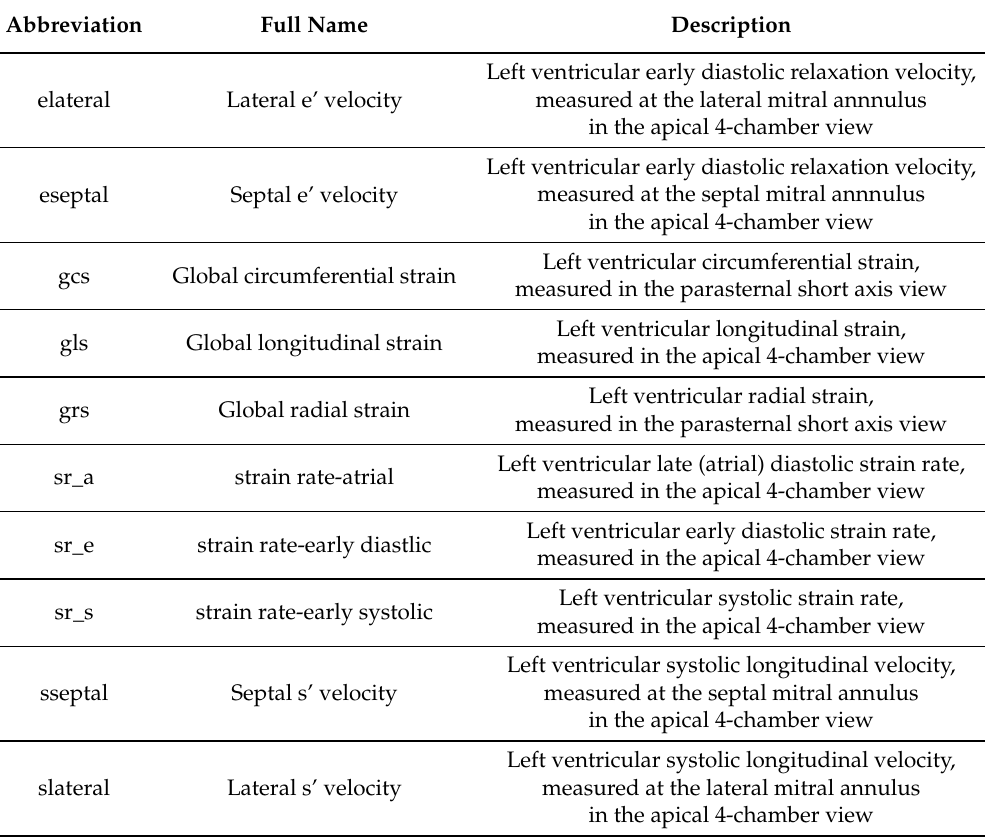
Table 2. Description of 9 phenotypic/outcome variables that are used to examine the significance of genetic-based hypertension subtype